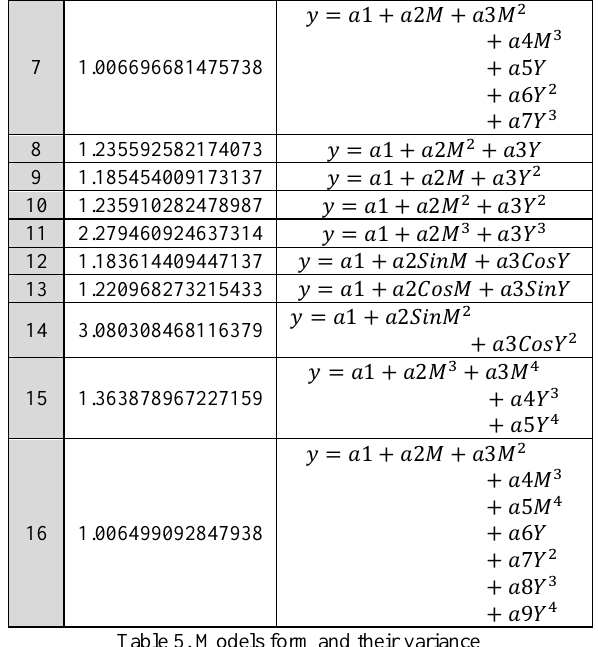
Table 5. Models form and their variance